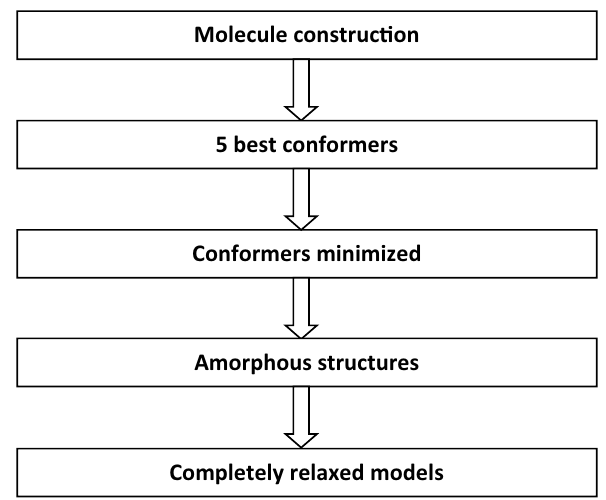
Fig. 2 Calculation of densities by molecular